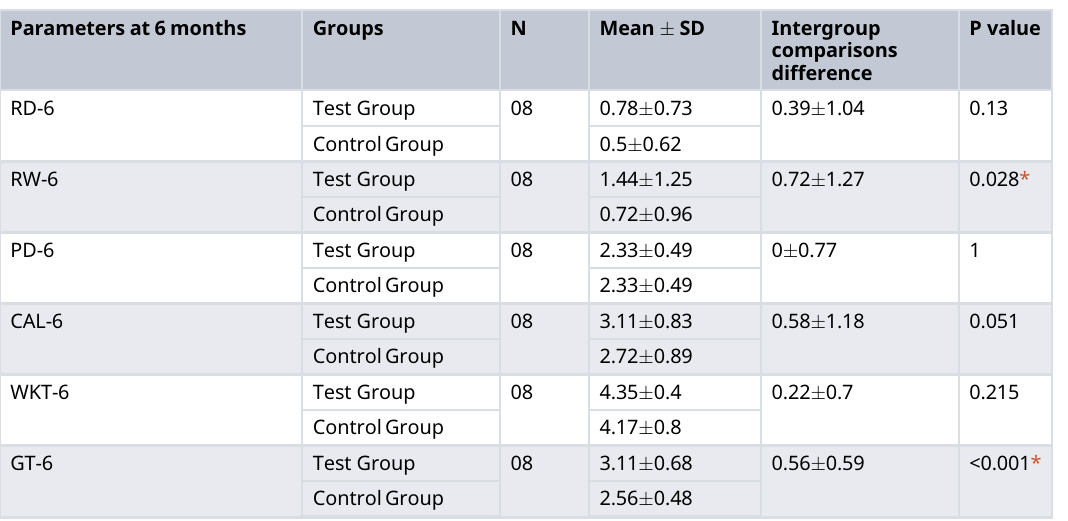
Table 5. Clinical outcomes at six